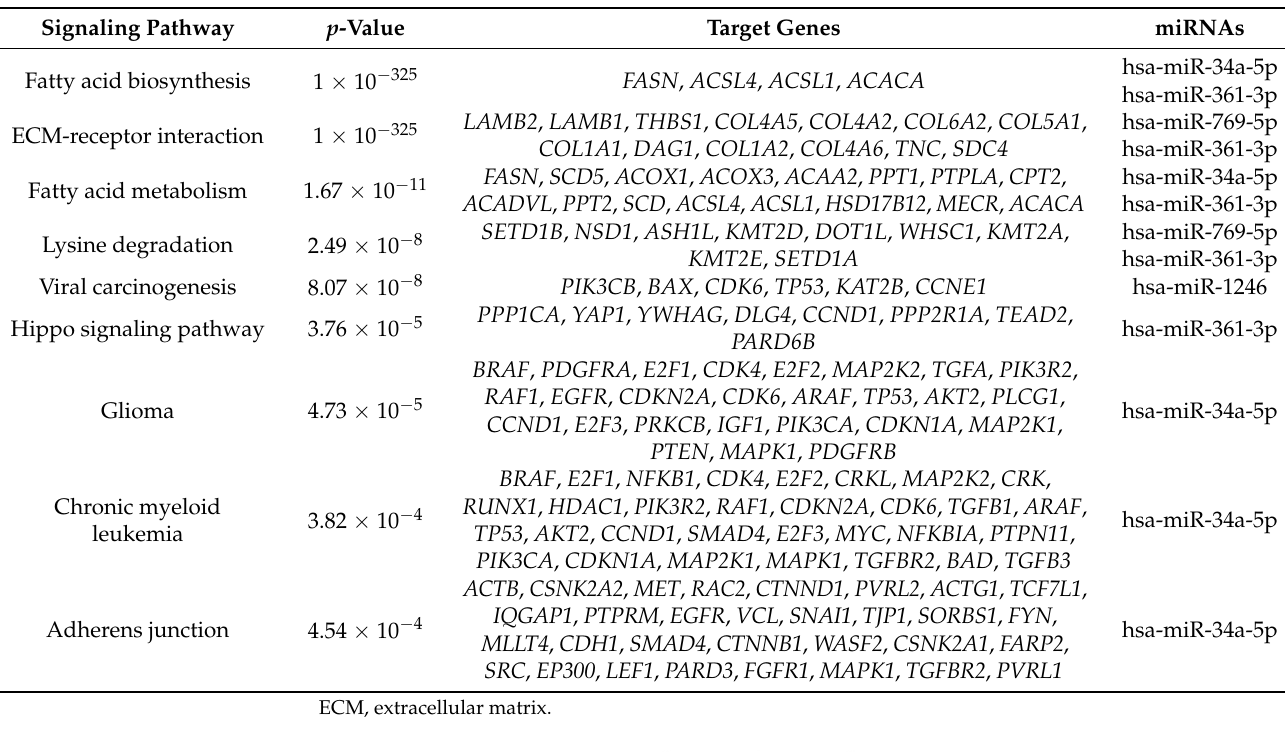
Table 4. KEGG pathway analysis involved in significantly differentially expressed miRNAs between FBXW7 wild-type and mutated rectal neuroendocrine tumors.